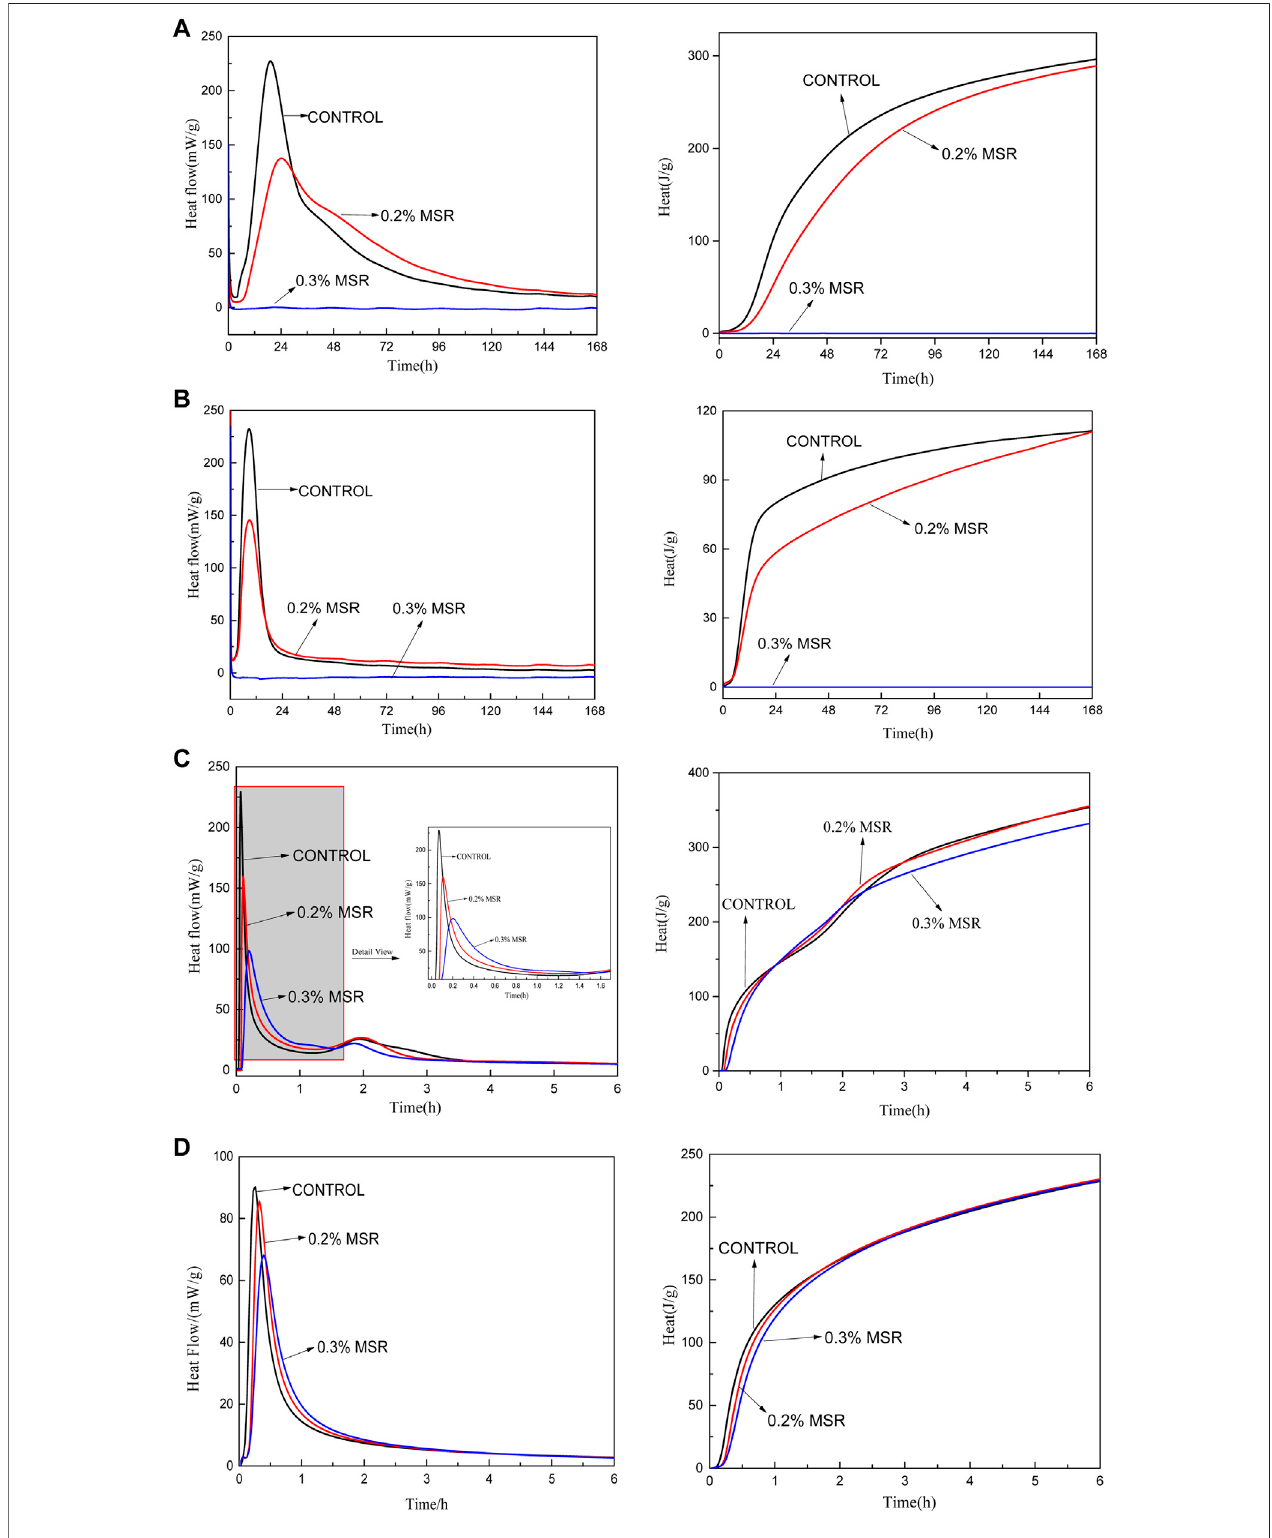
FIGURE 10 | Microcalorimetric curve of single mine paste with 0.4 W/C under the constant test temperature of 20 ° C showing heat fl ow rate and cumulative hydration heat: (A) C3S; (B) C2S; (C) C3A; (D) C4AF.